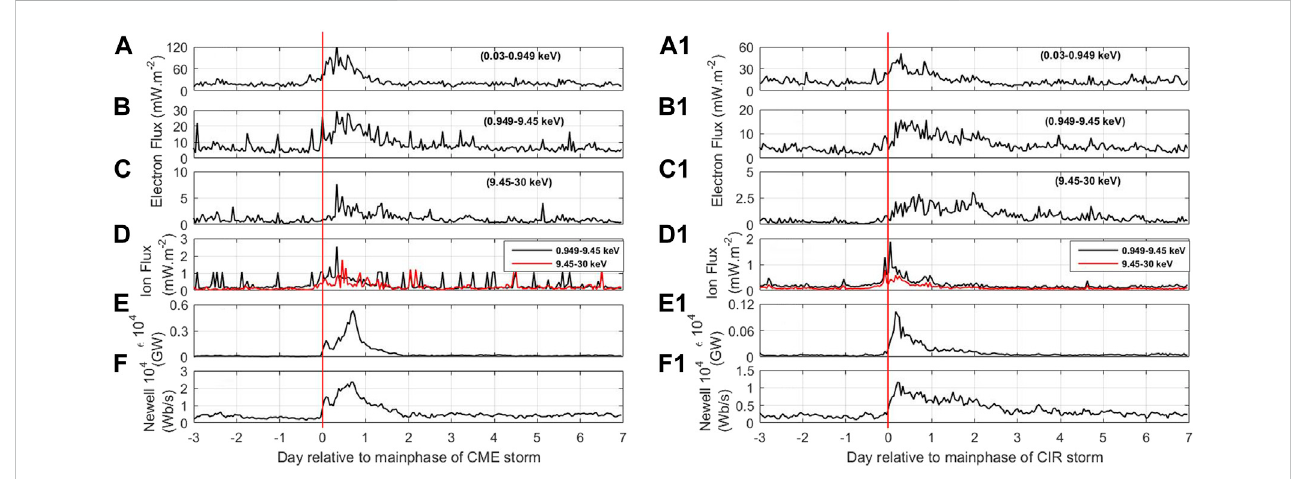
FIGURE 3 Superposed Epoch for (left) CME and (Right) CIR storms. (A – C) DMSP electron fl ux, (D) DMSP ion fl ux, (E) Akasofu coupling function and (F) Newell coupling function during CME storms. (A1 – F1) Same for CIR